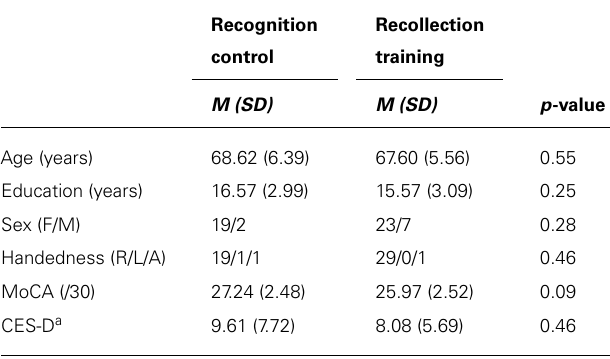
Table 1 | Participants’ demographic information.